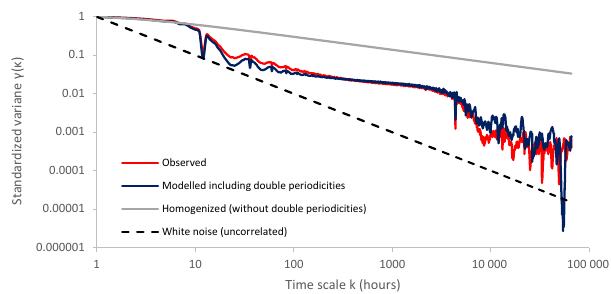
Figure 7. Climacogram of observed and simulated K T vs. white noise and a homogenized process without